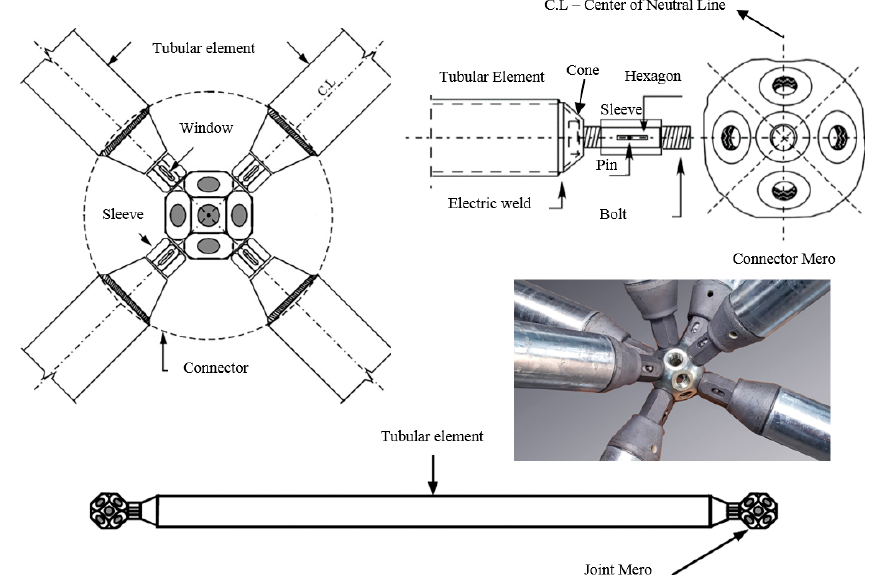
Figure 1. Connection manufactured in 1943, the system more widely used in space trusses in the world.